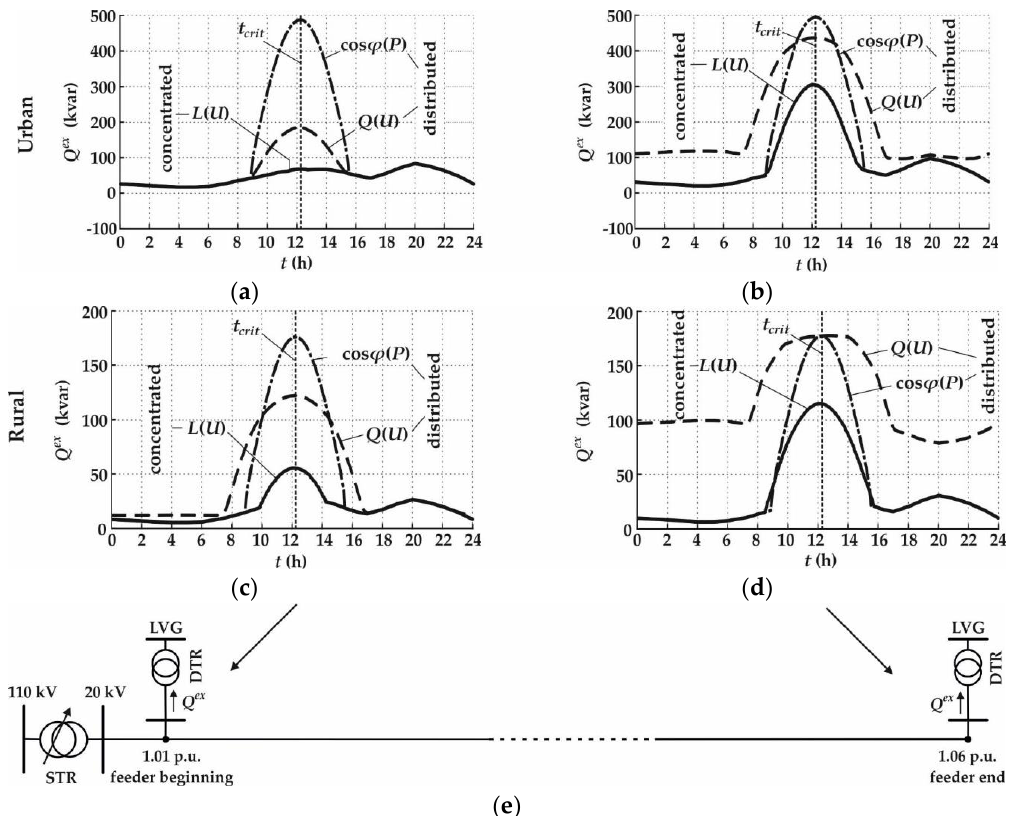
Figure 23. Daily Q e x for different control strategies and various LVGs connected at the MV feeder: ( a ) urban, connected at the feeder beginning; ( b ) urban, connected at the feeder end; ( c ) rural, connected at the beginning; ( d ) rural connected at the end; ( e ) overview of the MVG.